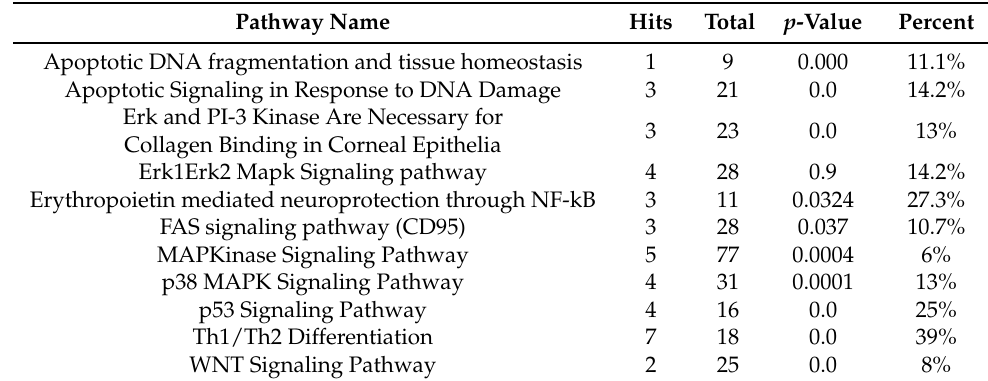
Table 2. Effect of AC3 knockout on cell death related signaling pathways.